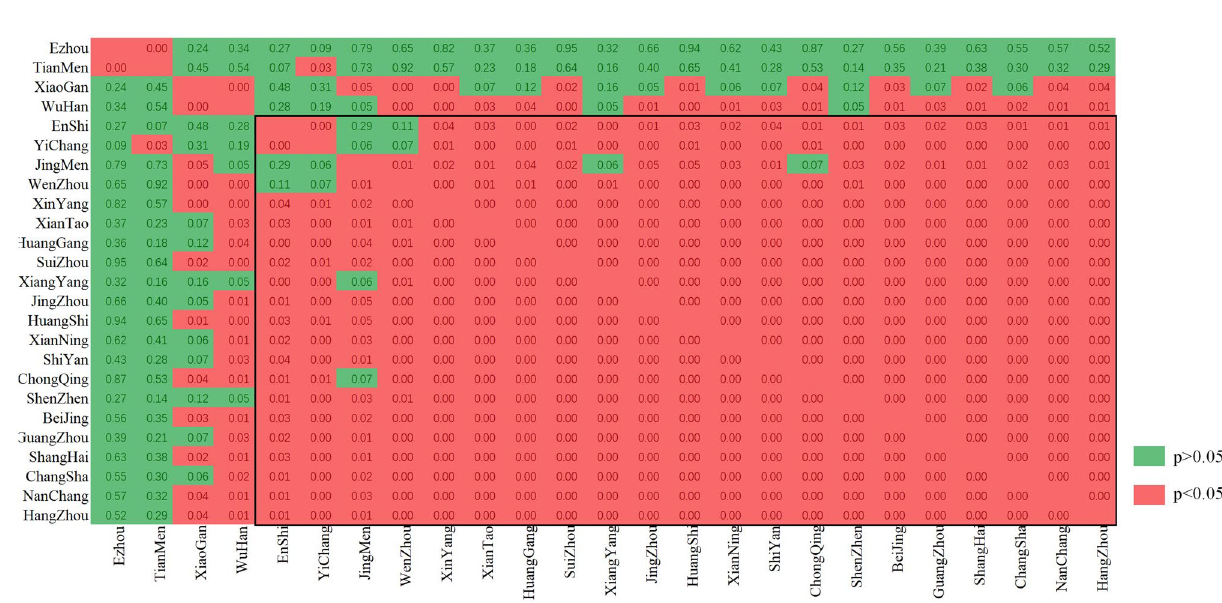
Figure 3. The correlation coefficient of the R time series among cities.